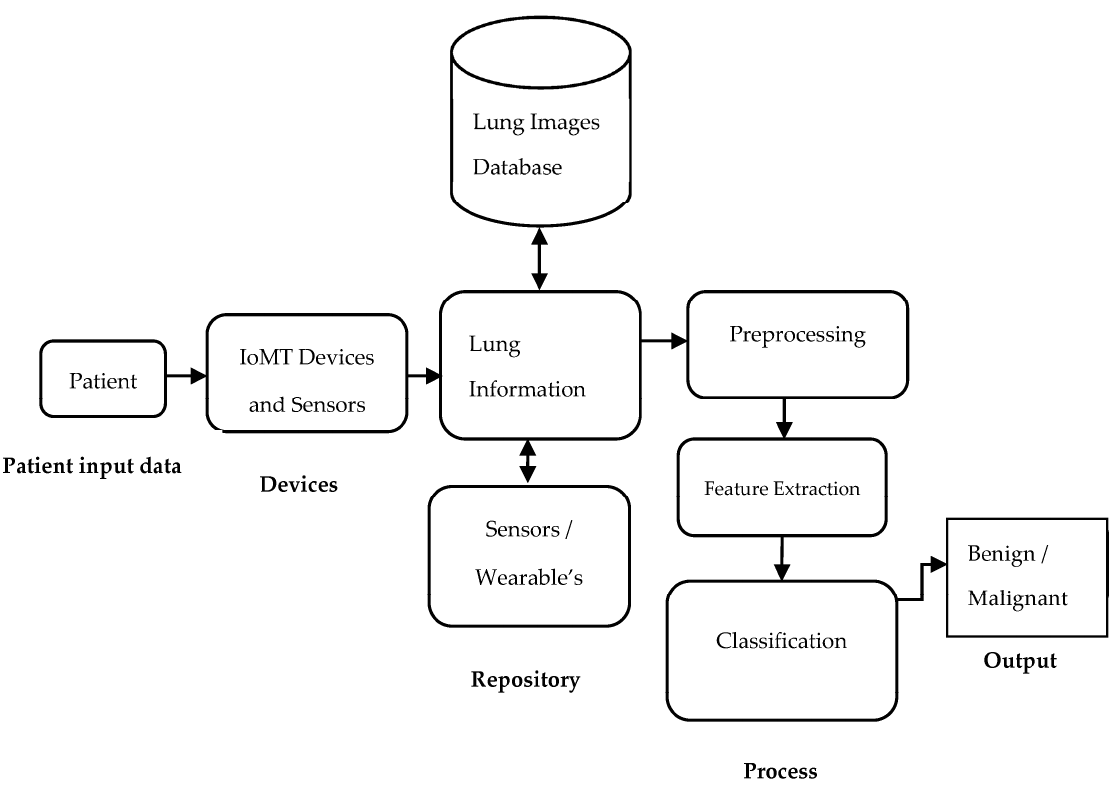
Figure 1. Pipeline for IoMT-based lung disease diagnosis.